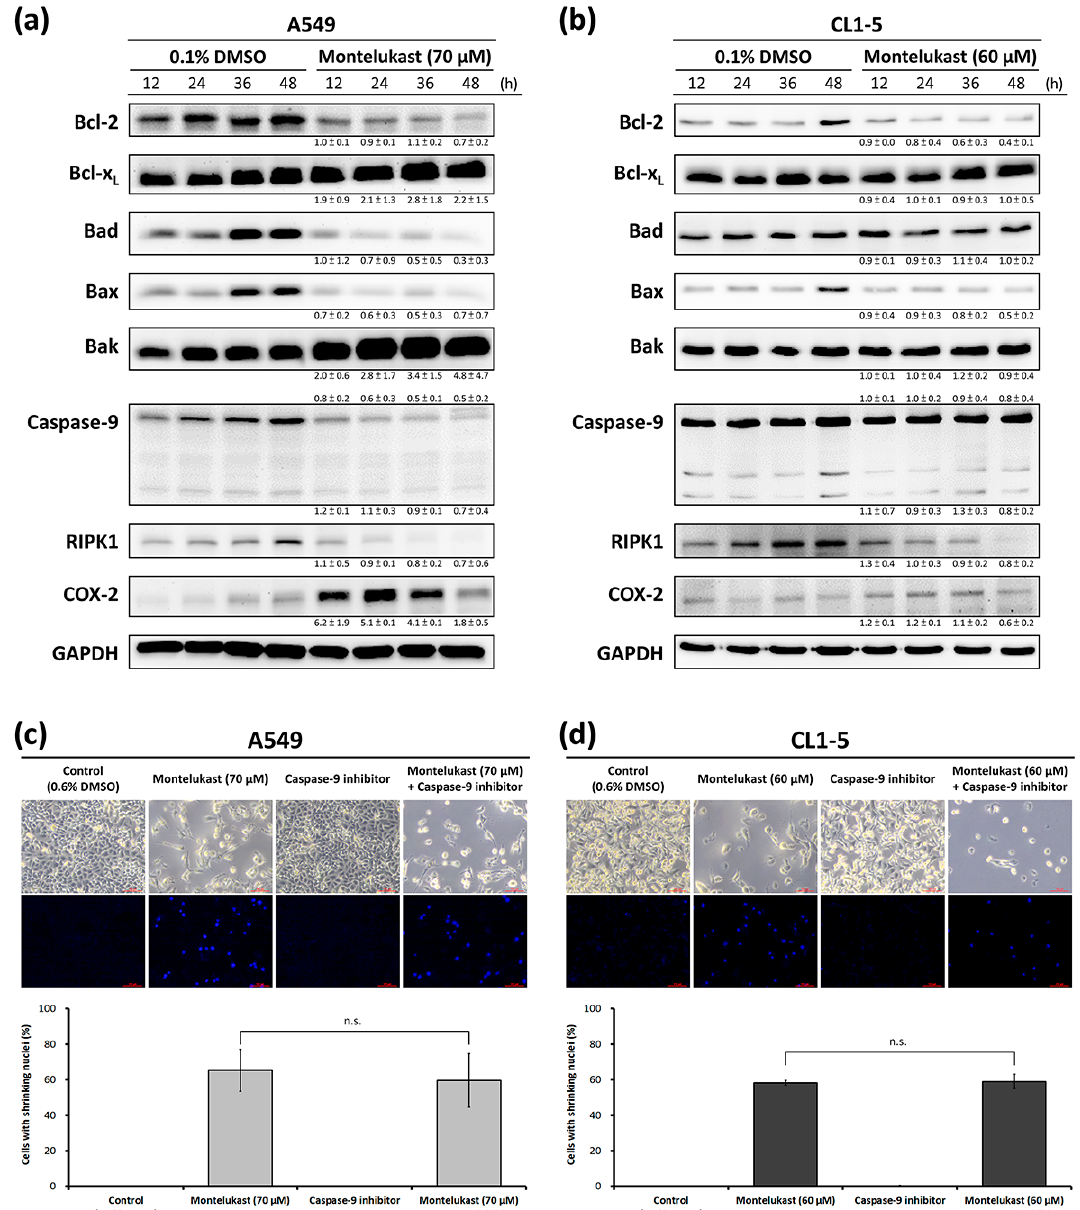
Figure 3. The montelukast-induced death of lung cancer cells did not depend on various proteins in the Bcl-2 family or caspase-9. ( a , b ) The cells (A549 and CL1-5) were treated with 0.1% dimethyl sulfoxide (DMSO) (control) or montelukast for the indicated time (12, 24, 36, or 48 h). The levels of various proteins in cell lysates were assessed with immunoblot assay. The results shown were representatives of at least three independent experiments performed on different days, along with the means ± SD of the relative expression levels to the corresponding control groups at the same time point; ( c , d ) the cells (A549 and CL1-5) were pre-treated with or without a specific caspase-9 inhibitor (20 µ M) for 1 h, and then treated with 0.6% DMSO (control) or montelukast for 48 h. The percentages of cells with shrinking nuclei were calculated. All results were expressed as the mean ± SD of three independent experiments performed on different days. n.s., no significant difference ( p > 0.5).